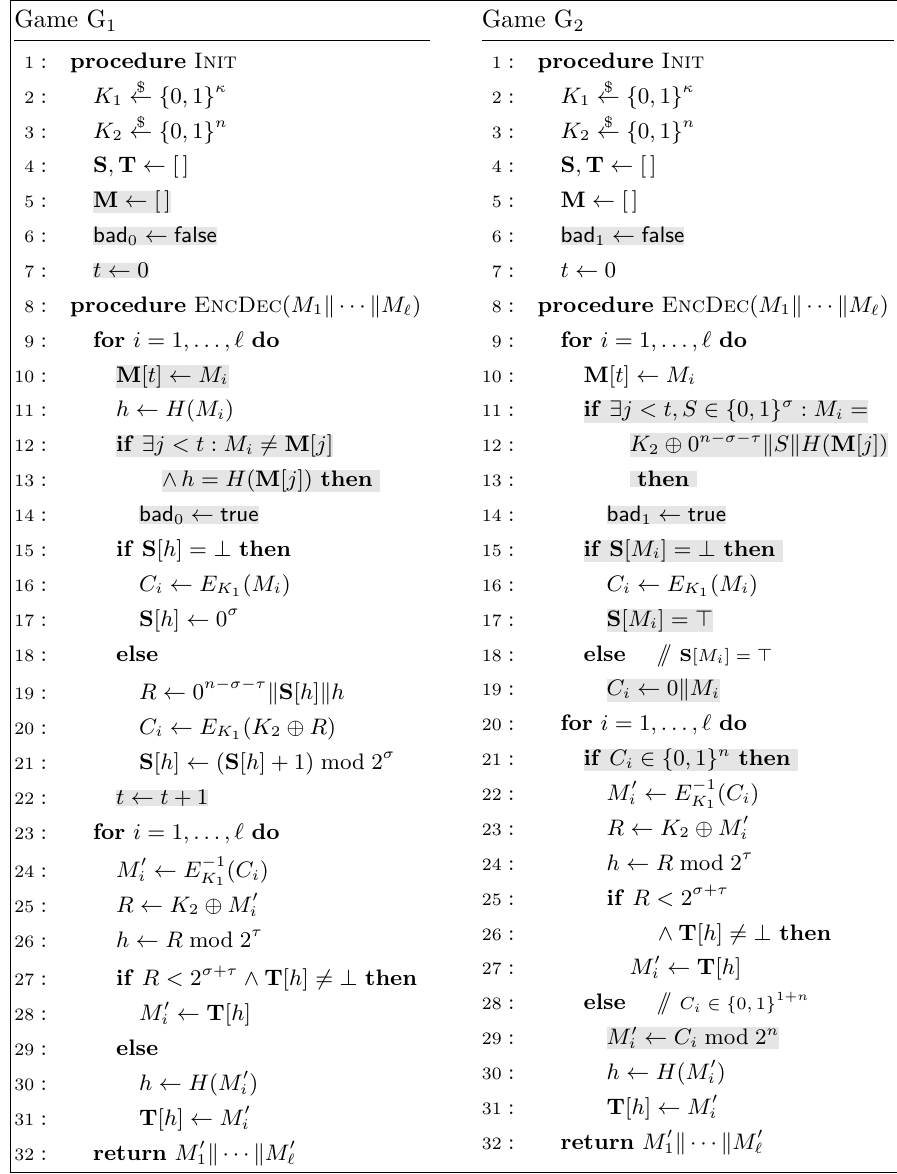
Figure 9: Games G 1 and G 2 for the proof of Theorem 2. Changes and additions from game G to game G are highlighted in the description of G 0 1 from game G to game G are highlighted in the description of G 1 2